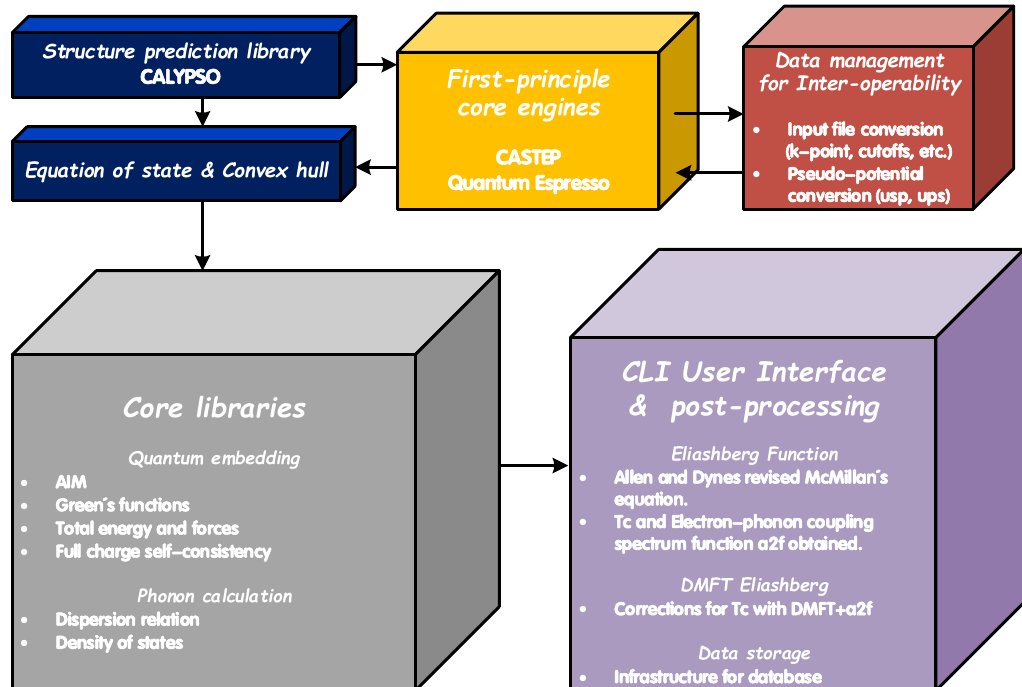
Figure 5. DFT inter-operability for a consistent many-body platform. Schematic overview of the main modules of the theoretical platform and its interrelations. Firstly, structures are predicted by Crystal structure AnaLYsis by Particle Swarm Optimization (CALYPSO), via Gibbs enthalpies for the equation of state and convex hull. The underlying core engines are the CASTEP and Quantum Espresso DFT software. Inter-operability between QE and CASTEP is achieved via format conversion of input files, pseudo-potentials, and k -point grids. Core libraries are used to provide the many-body corrections, via quantum embedding, which in turn provides corrected forces and energies. In post-processing, the Eliashberg function and superconducting T c are obtained with the DMFT+a2F approach. Finally, data are archived for future usage in